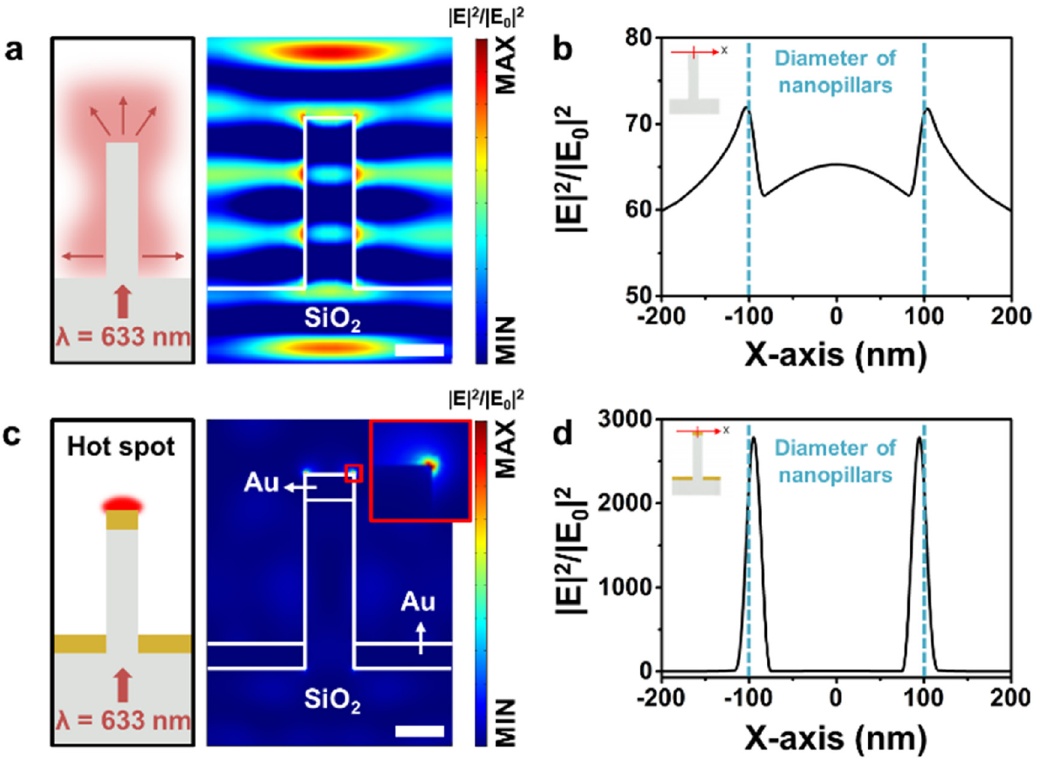
Figure 2: Normalized electric field-intensity distributions of DNPs and HNPs. (a) Schematic of subwavelength photonic waveguides and calculatedelectric field of the cross section of DNPs. (b) Optical X -axis line pro fi le at the tip of DNPs.The full width at halfmaximum(FWHM)of thetwoopticalmaxima,asthebasicresultofevanescentwaves,isapproximately40nm.(c)Schematicimageofplasmonconcentrationatthe tips of HNPs. (d) Two optical hotspots at gold nanodisks representing highly concentrated electrical fi elds that can enhance the emission intensity of fl uorophores in the nanoscale volume (Height: 700 nm, thickness of gold nanodisks and nano fi lms: 100 nm, period: 1 μ m, wavelength of incident light: 633 nm, scale bars: 100